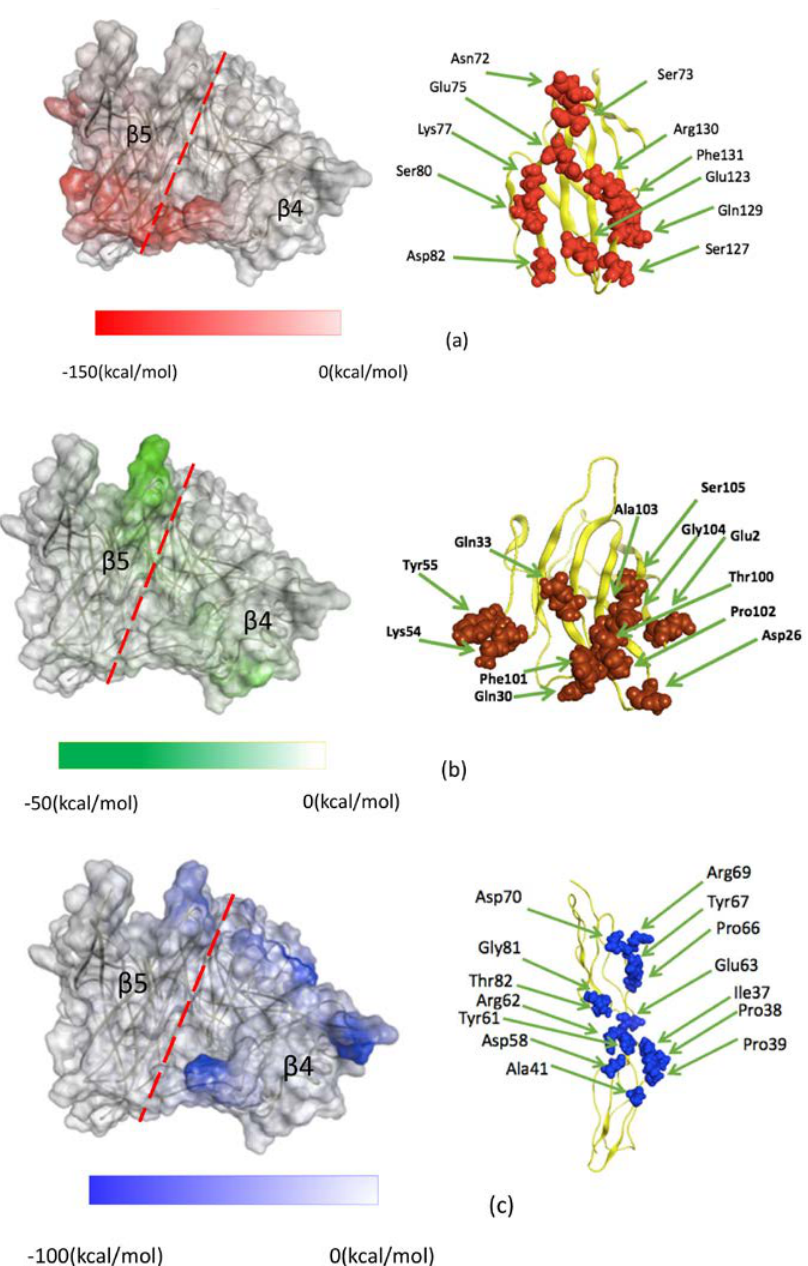
Figure 3. Interfaces of MVH and the respective three receptors. ( Left ) β 4 and β 5 strand regions on the MVH surface that show strongly attractive interactions with the three receptors: ( a ) SLAM (red), ( b ) Nectin-4 (green), and ( c ) CD46 (blue). The deepness of the color represents the strength of the IFIE sum associated with the fragment (MVH residue) at that position. The dashed line represents the approximate boundary between the β 4 and β 5 regions. ( Right ) Residues on the receptor surface that show importantly attractive interactions with MVH: ( a ) SLAM, ( b ) Nectin-4, and ( c ) CD46.